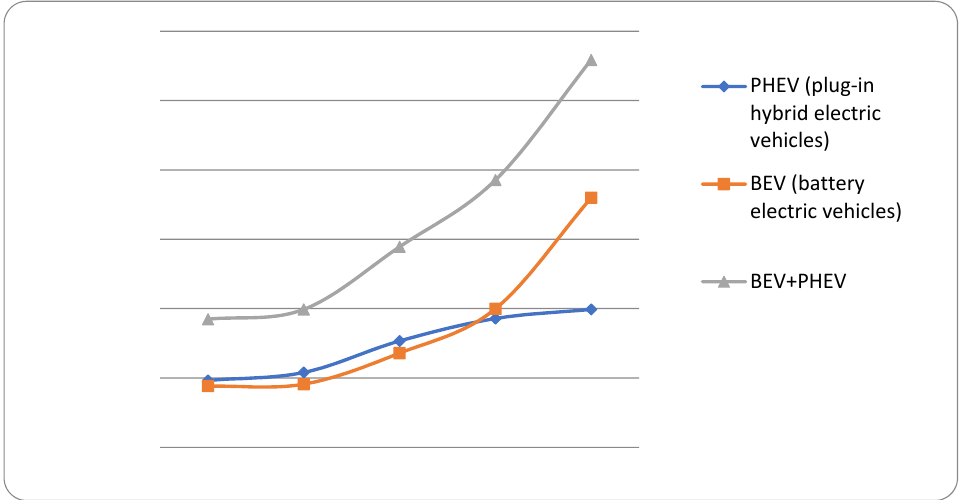
Figure 2. Annual registrations of battery electric vehicles and plug-in hybrid electric vehicles in Europe, (source: elaborated by authors based on [17]).